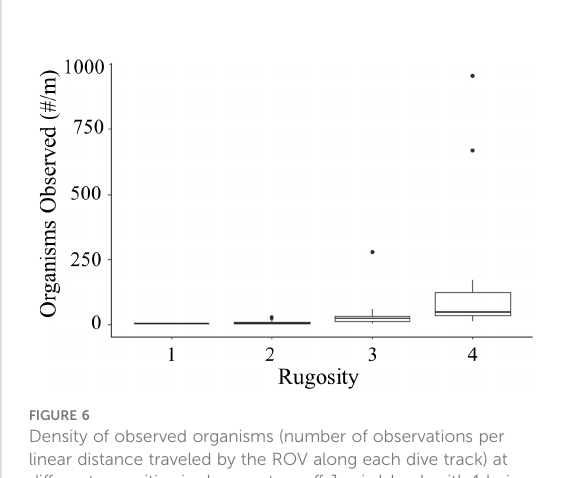
FIGURE 6 Density of observed organisms (number of observations per linear distance traveled by the ROV along each dive track) at different rugosities in deep waters off Jarvis Island, with 1 being the smoothest sea fl oor, 2 fl at sea fl oor with rocks <50 cm, 3 medium-sized rocks 0.5 – 1.5 m, and 4 being the most complex substrate with rocks >1.5